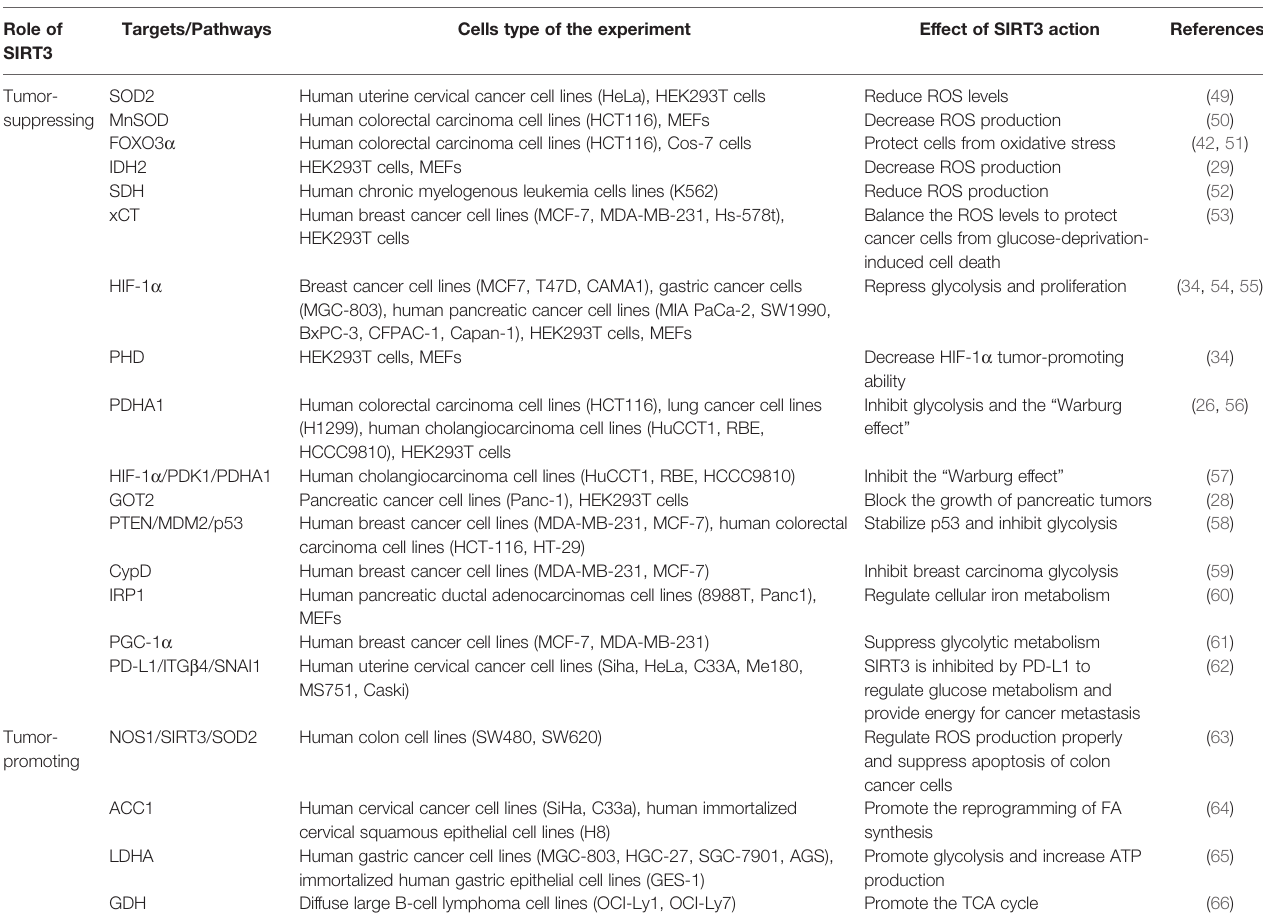
TABLE 1 | Regulation of cancer metabolism reprogramming by